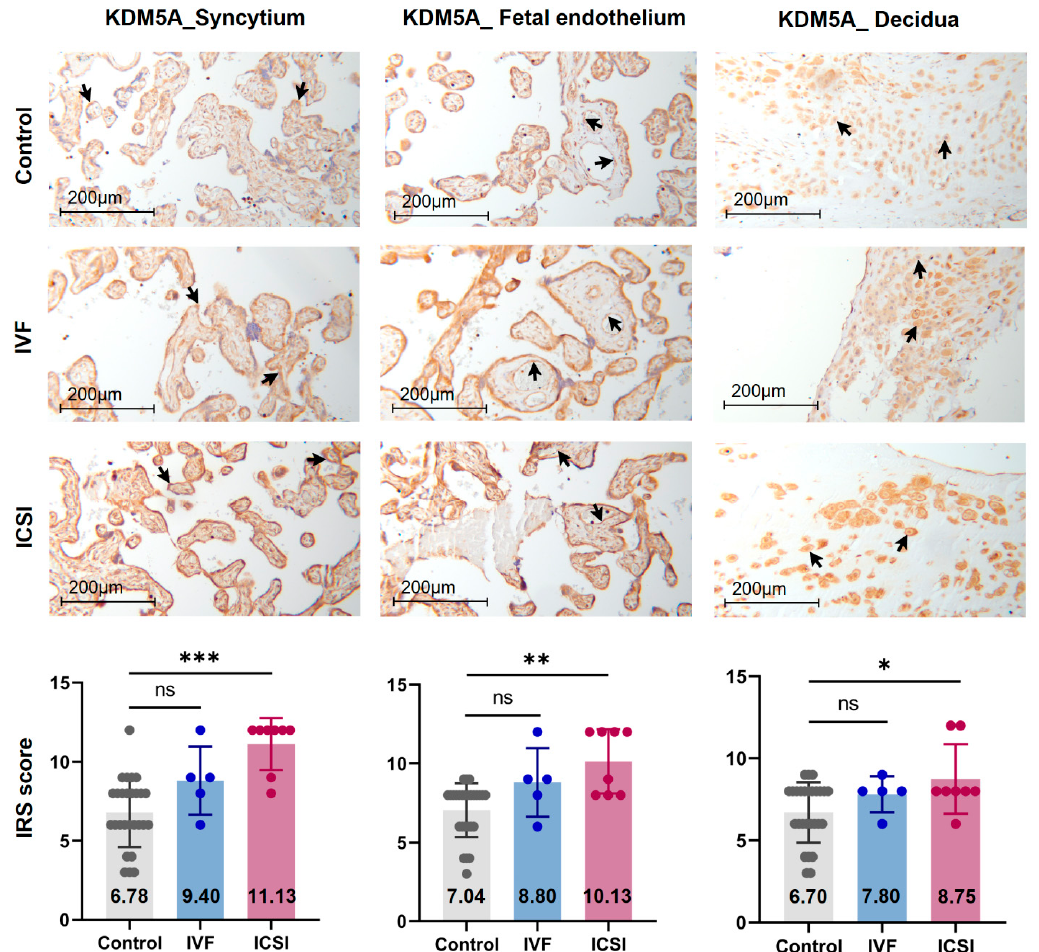
Figure 6. KDM5A expression was increased in ICSI-derived placentas. Compared with natural conception placentas, ICSI placentas showed higher levels of KDM5A in syncytium, fetal endothelium, and decidua, while IVF placentas showed no significant difference. Boxplots showing the IRS distribution among natural conception ( n = 27), IVF ( n = 5), ICSI ( n = 8) groups along with significance levels indicated as p -value of the Mann-Whitney U -test. IRS = staining intensity × percentage of positive cells. Data were reported as mean ± SD. The arrows in the first, second, and third columns respectively pointed towards syncytial trophoblast cells, foetal endothelial cells and extravillous trophoblast cells. The numbers inside the columns represented the mean value of the corresponding IRS. * p < 0.05; ** p < 0.01; *** p < 0.001.